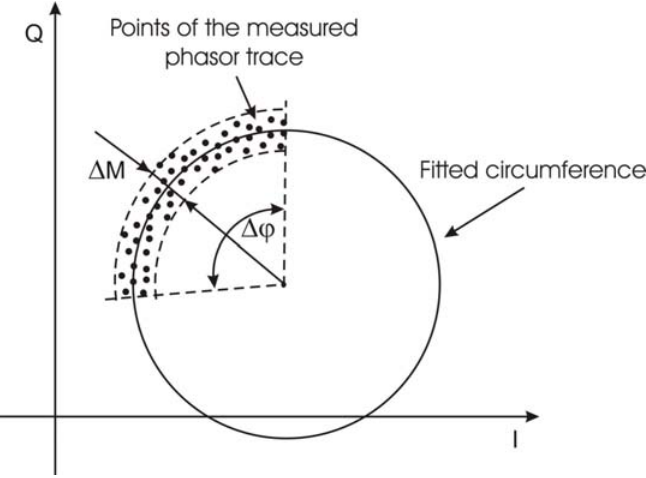
Figure 3. Representation of the dispersion of the measured phasor trace:  M is the dispersion along the radial direction of the circumference;  is the dispersion along the angle under the arc of